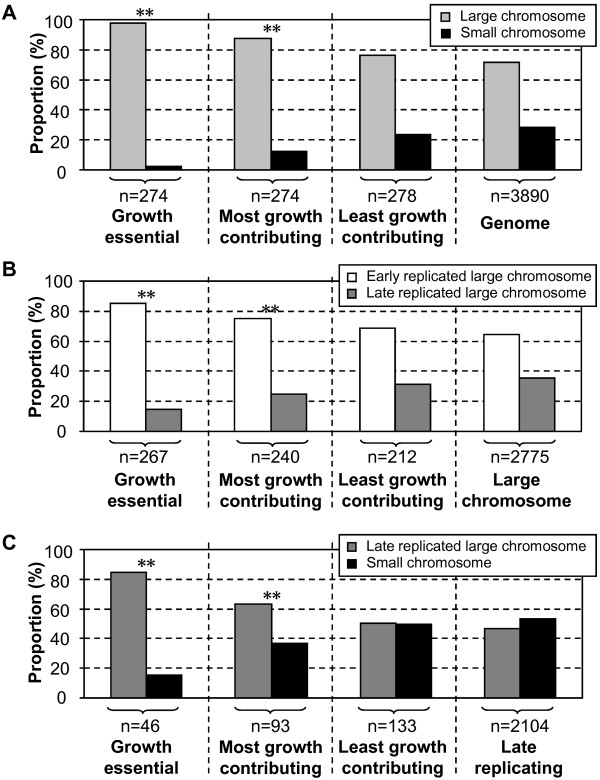
Distribution of growth related genes within the V. cholerae genome. Distributions of orthologs to growth essential, the most growth contributing and the least growth contributing E. coli genes between (A) the large and the small chromosome, (B) the origin- and the terminus-proximate part of the large chromosome and (C) the terminus-proximate part of the large chromosome and the small chromosome is shown together with distributions of all V. cholerae genes. Light grey bars represent the large chromosome, black bars the small chromosome, white bars the origin-proximate part of the large chromosome and dark grey bars the terminus-proximate part of the large chromosome. Sizes (n) of each group are shown and stars indicate that distributions are significantly different from an average determined by chi-square tests for comparison of two proportions (* P < 0.05, ** P < 0.01).